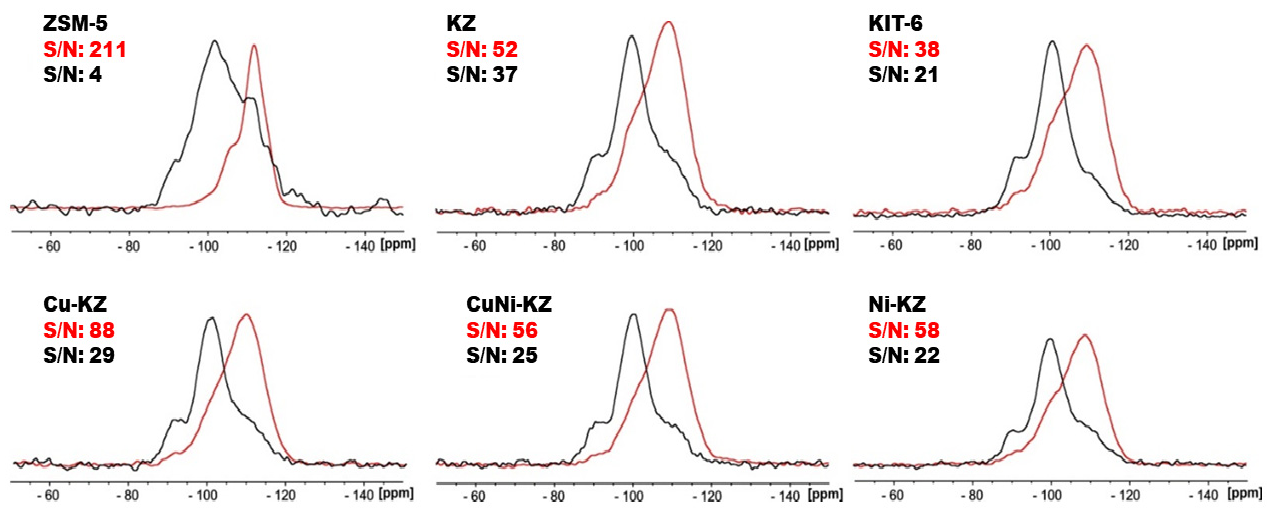
Figure 5. Comparison of the 1 H → 29 Si CP (black) and single-pulse (red) 29 Si NMR spectra of the studied materials. The signal-to-noise (S/N) ratio in the two types of experiments at the same number of scans is given for comparison.